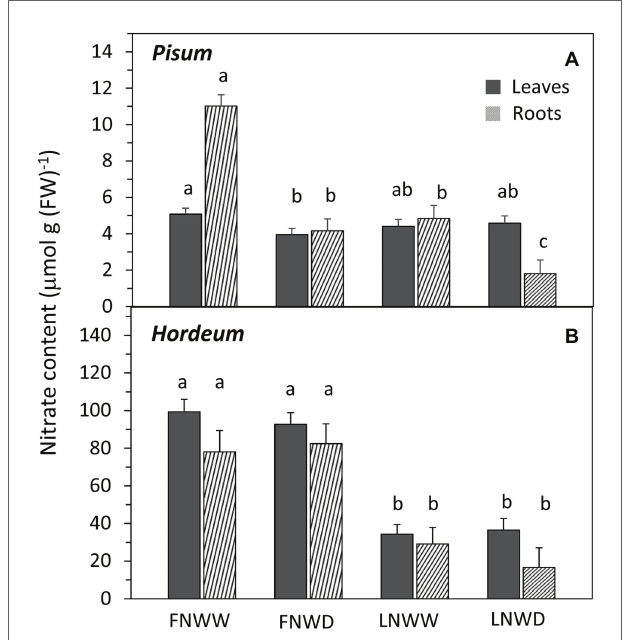
FIGURE 1 | Mean transpiration rates (TRs) of Pisum sativum (A) and Hordeum vulgare (B) plants after 2–6 days treatment with different water and nitrogen availability. FNWW plants received 4 mM nitrate (NO3 − ) daily, FNWD plants received 4 mM NO3 − at the start but no water during the sampling